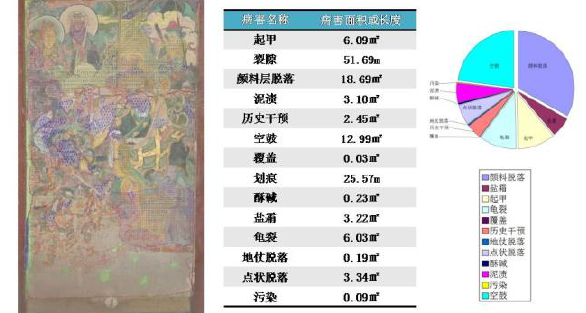
Figure 2427 detailed survey of the Bao Fan mural degradation We can see that continuing degradation related to the environmental humidity, and which is difficult to control, affects 16.8% of the Main Hall mural. In conclusion the next step, based on the result of the past survey mapping, is to develop a plan to prevent the mural from being destroyed any further and begin the reconstruction of the